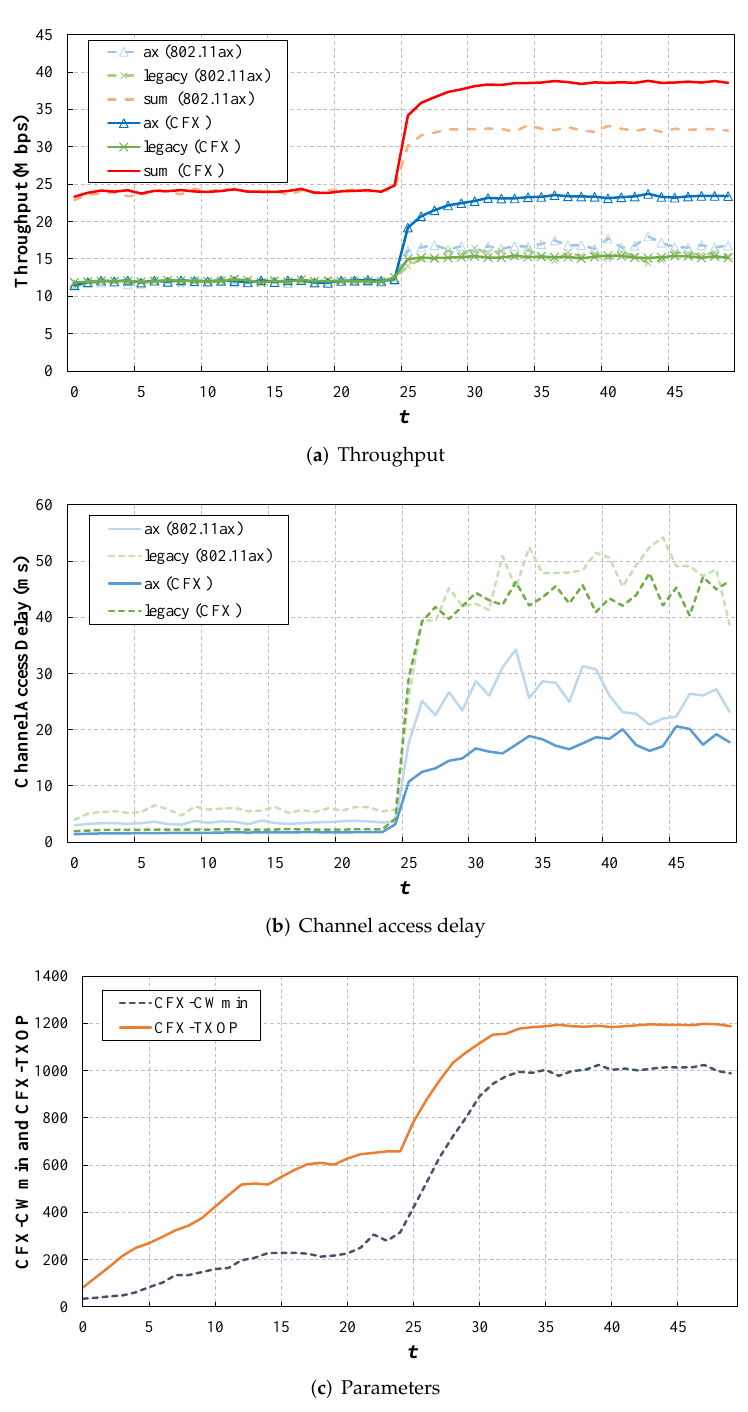
Figure 8. CFX according to varying network status. We increased the number of users from 4 to 20 at 𝑡 = 25. At first, the agent tended to use the access schemes of CFX less often, but as the access probability increased, it achieves higher values for CFX-CWmin and